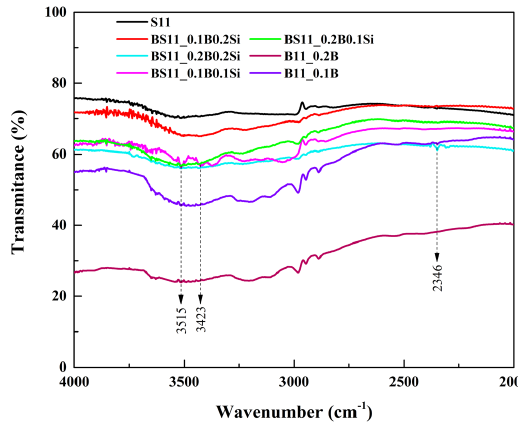
Figure 5. IR spectra in the range of 4000-2000 cm -1 of AEL samples with and without boron added to different compositions.